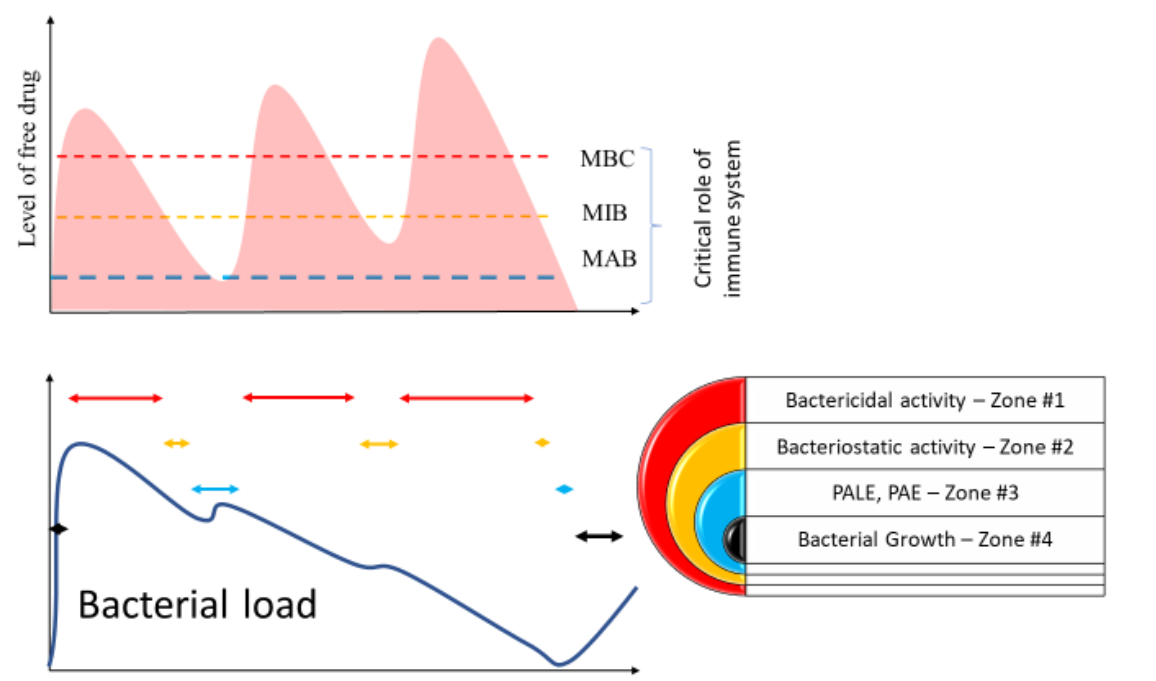
Figure 2. The level of the antibiotics are gradually increasing over the time to cross the MAB, MIB and MBC threshold, but only above MBC thresholds can the antibiotics eradicate infection instead of augmenting the immune system function.